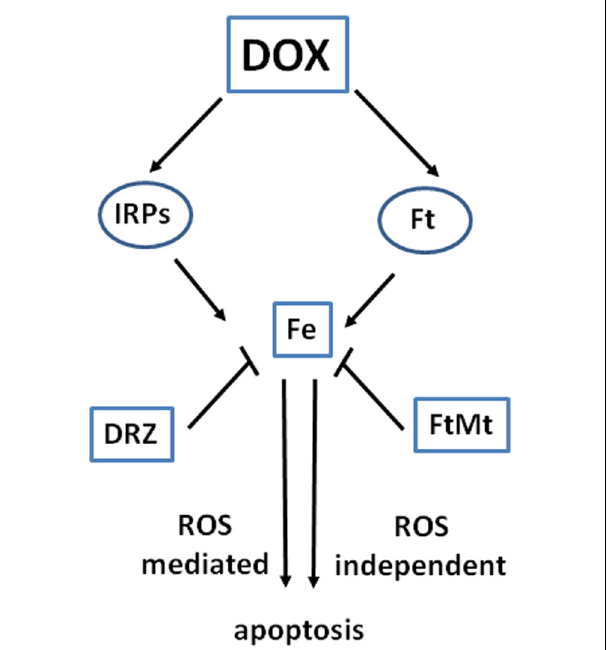
FIGURE 2 | Interaction of DOX with proteins of iron metabolism. The interaction of DOX with the functions of iron regulatory proteins (IRPs) and ferritin (Ft) affects iron homeostasis and may lead to ROS-dependent and independent damage and apoptotic cell death. Iron sequestration by the iron chelator dexrazoxane (DRZ) or mitochondrial ferritin FtMt may prove